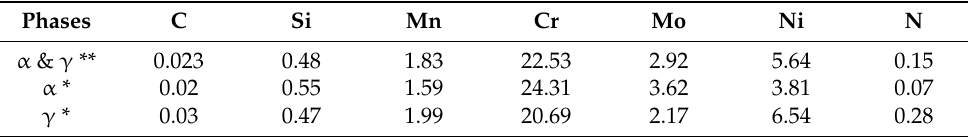
Table 6. Chemical composition of 1.4462 X2CrNiMoN 22 5 3 (UNS S31803), in mass percent.